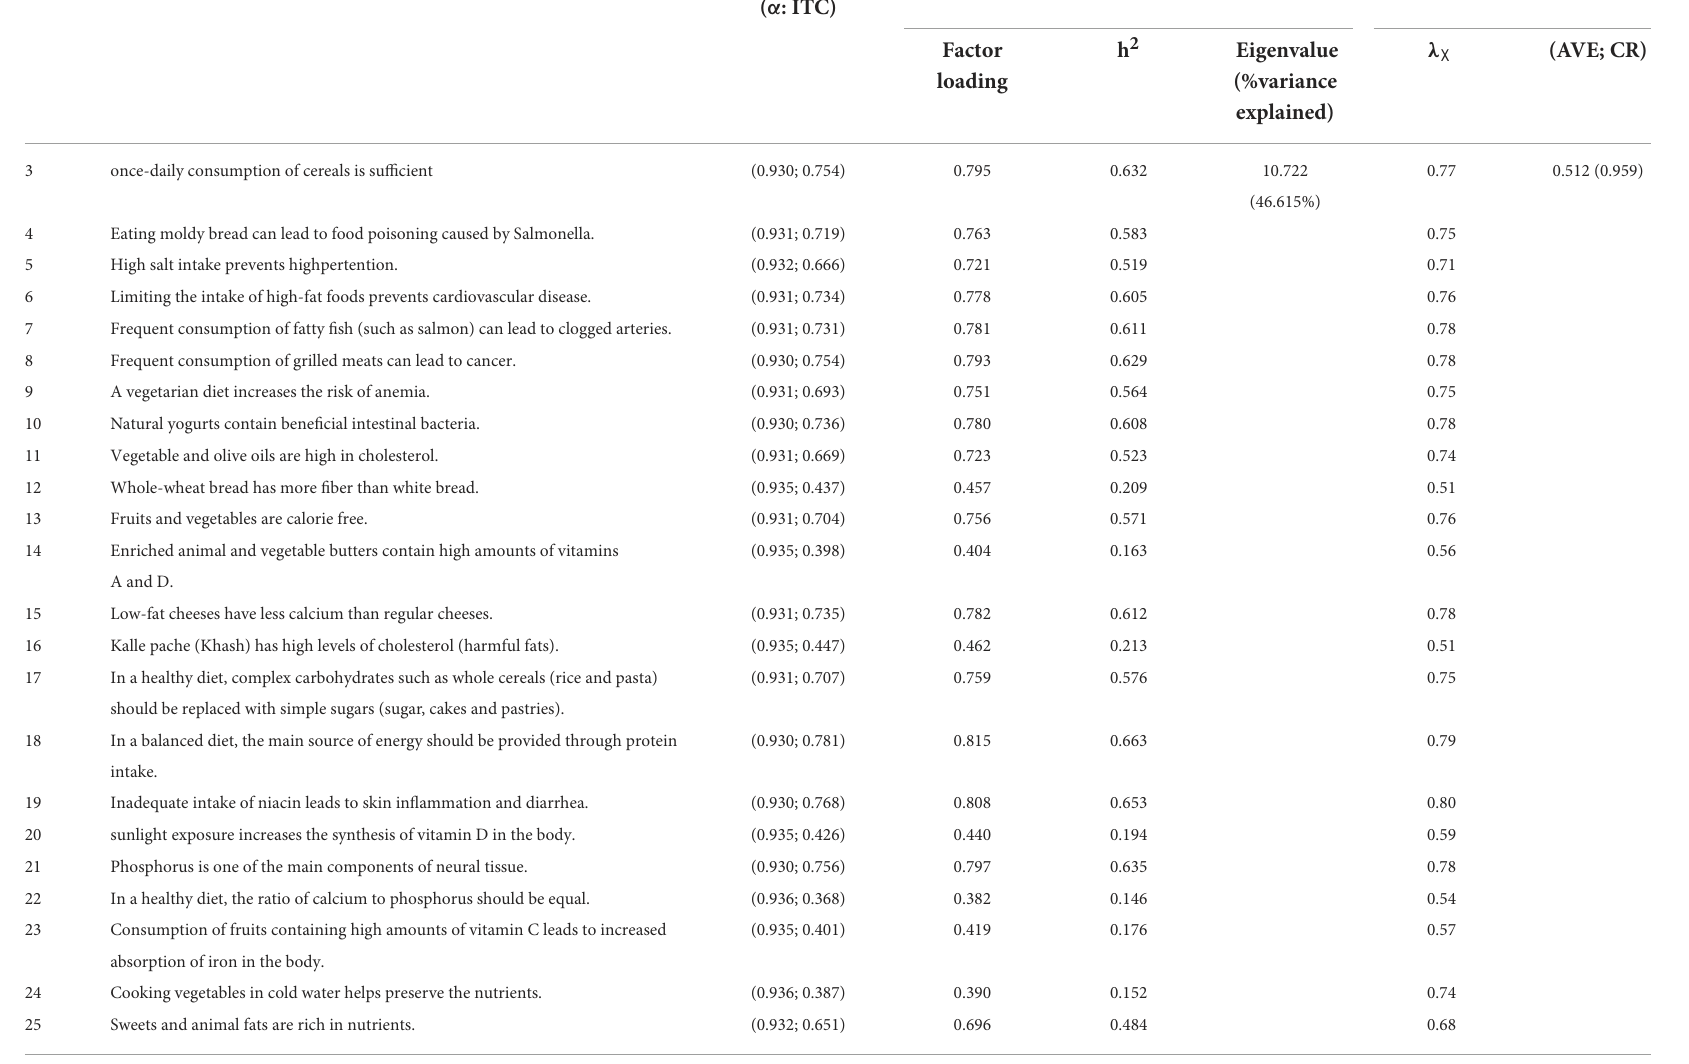
TABLE 5 Results of the exploratory and confirmatory factor analysis of the nutrition beliefs scale. No